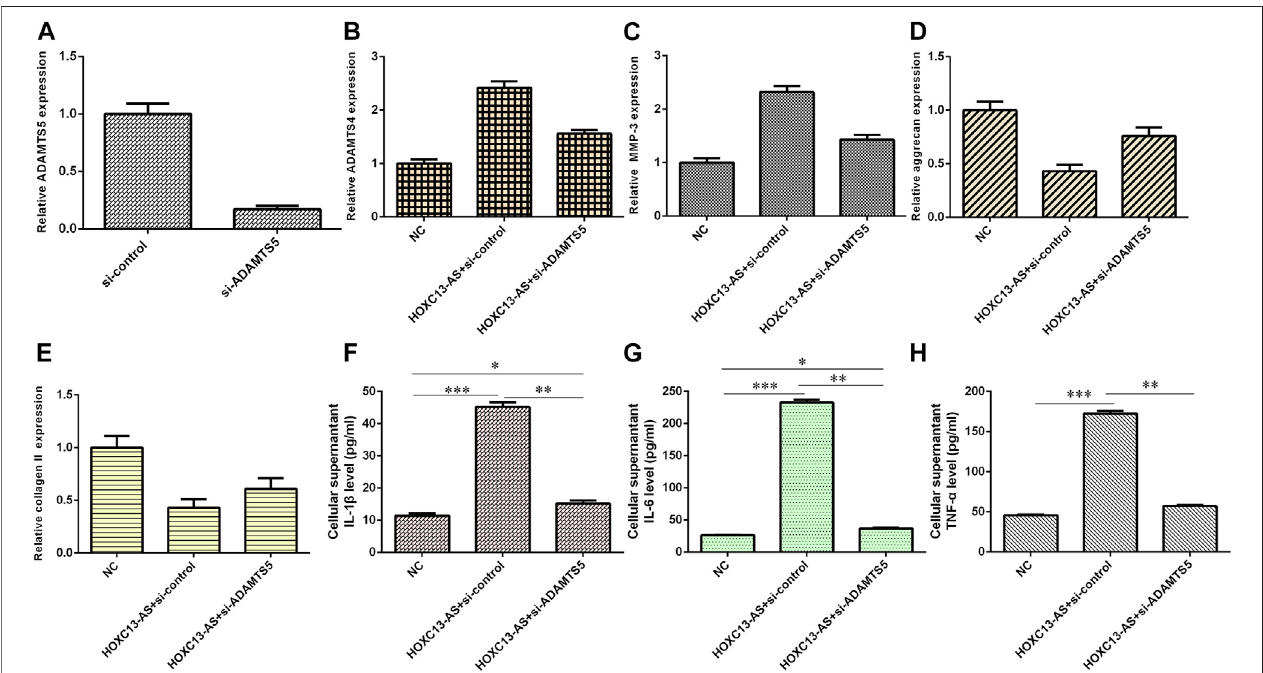
FIGURE 7 | HOXC13-AS induced in fl ammatory cytokine expression and ECM degradation by modulating miR-497-5p/ADAMTS5. (A) ADAMTS5 was obviously downregulatedinNPcellsaftertreatmentwithADAMTS5siRNA. (B) ADAMTS4expressionwasmeasuredbyqRT-PCR. (C) MMP-3expressionwasmeasuredbyqRT- PCR. (D) Aggrecan expression was measured by qRT-PCR. (E) OXC13-AS overexpression inhibited collagen II expression, while downregulation of ADAMTS5 expression enhanced this effect. (F) IL-1 β expression was determined by ELISA. (G) IL-6 expression was determined by ELISA. (H) TNF- α expression was determined by ELISA. * p < 0.05, ** p < 0.01, and *** p <